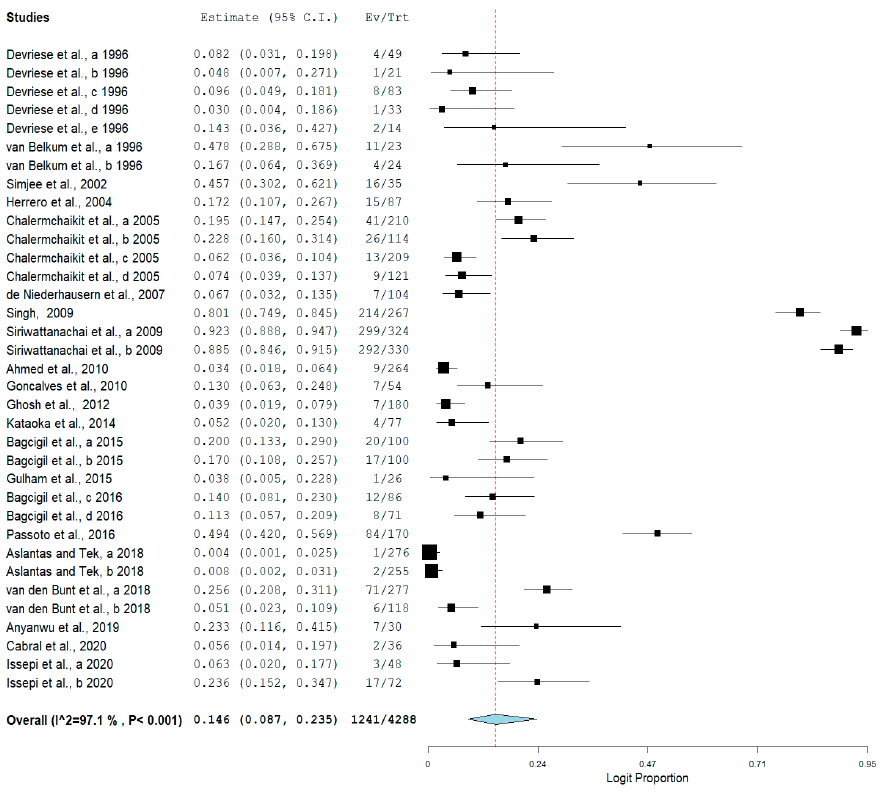
Figure 2. Forest plot showing the pooled prevalence of VRE in companion animals.